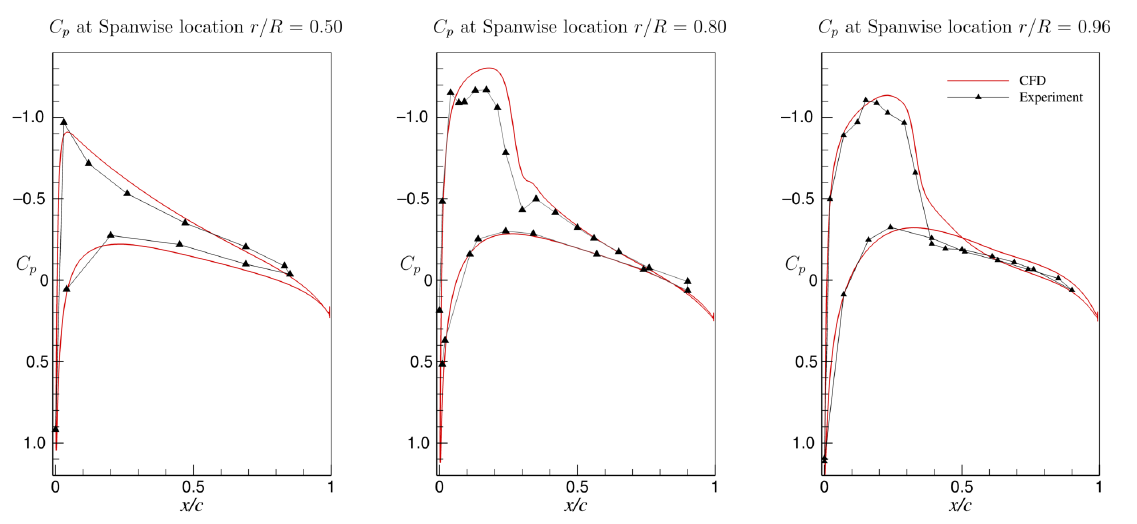
Figure A5. Pressure coefficient at different span-wise locations on the blade: comparison between numerical simulation with Spalart–Allmaras turbulence model and experiment result [37]).